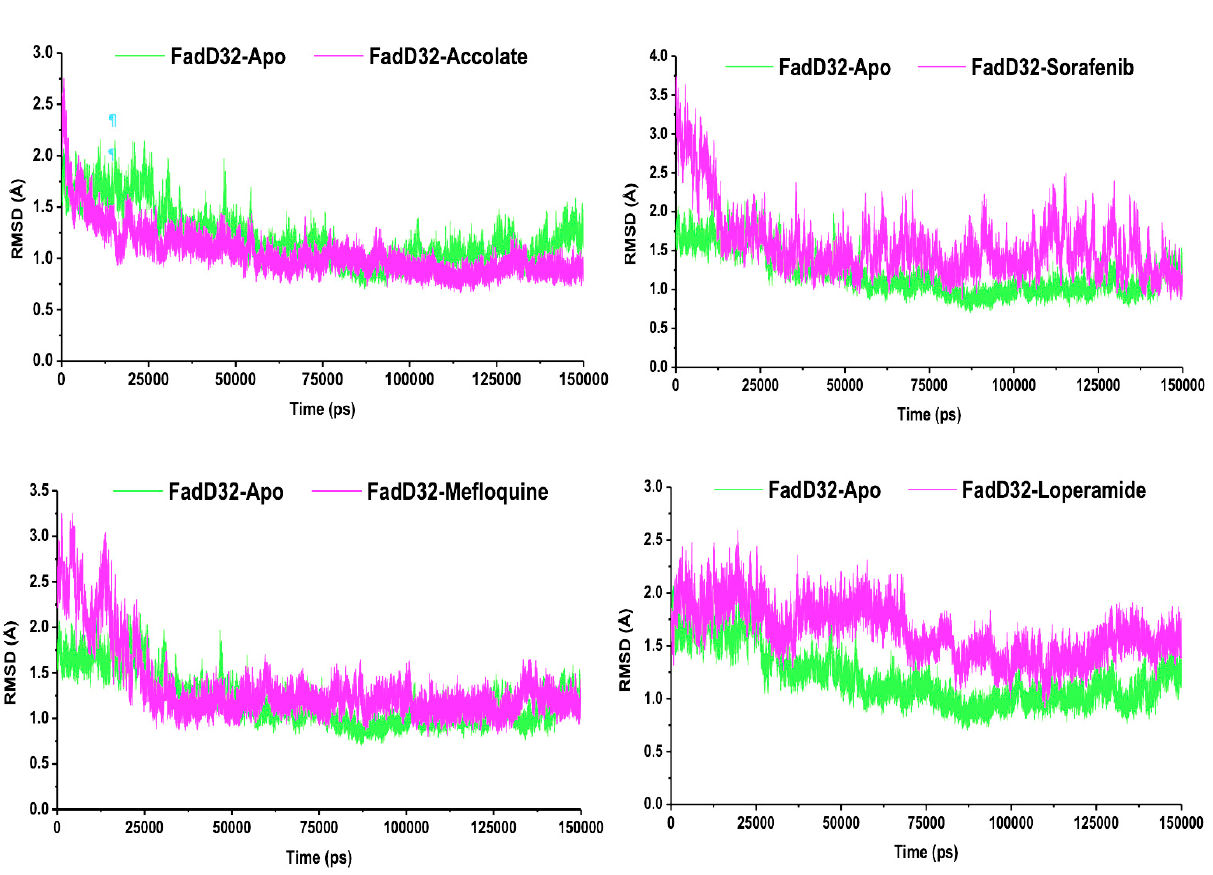
Figure 5. RMSD Plot of FadD32-Apo, FadD32-Accolate, FadD32-Sorafenib,